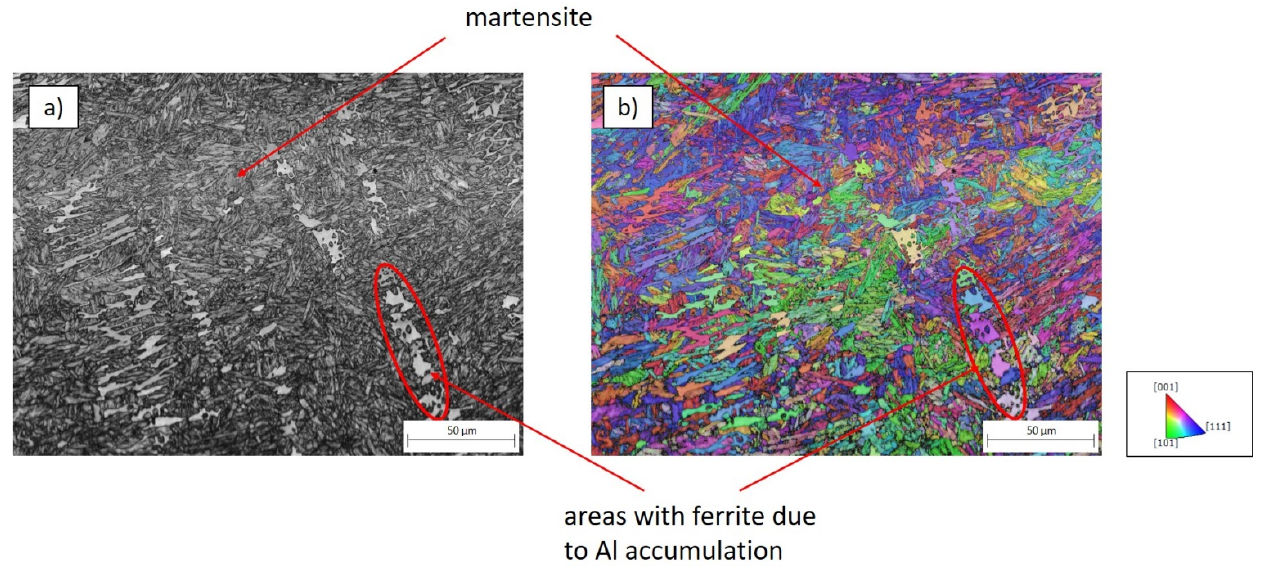
Figure 11. Comparison of the phase formation within the weld metal of tailored blanks, jointed with soundwave superposition at lower frequencies. ( a ) IQM and ( b ) IPFM. Grain orientations plotted parallel to the traverse direction.